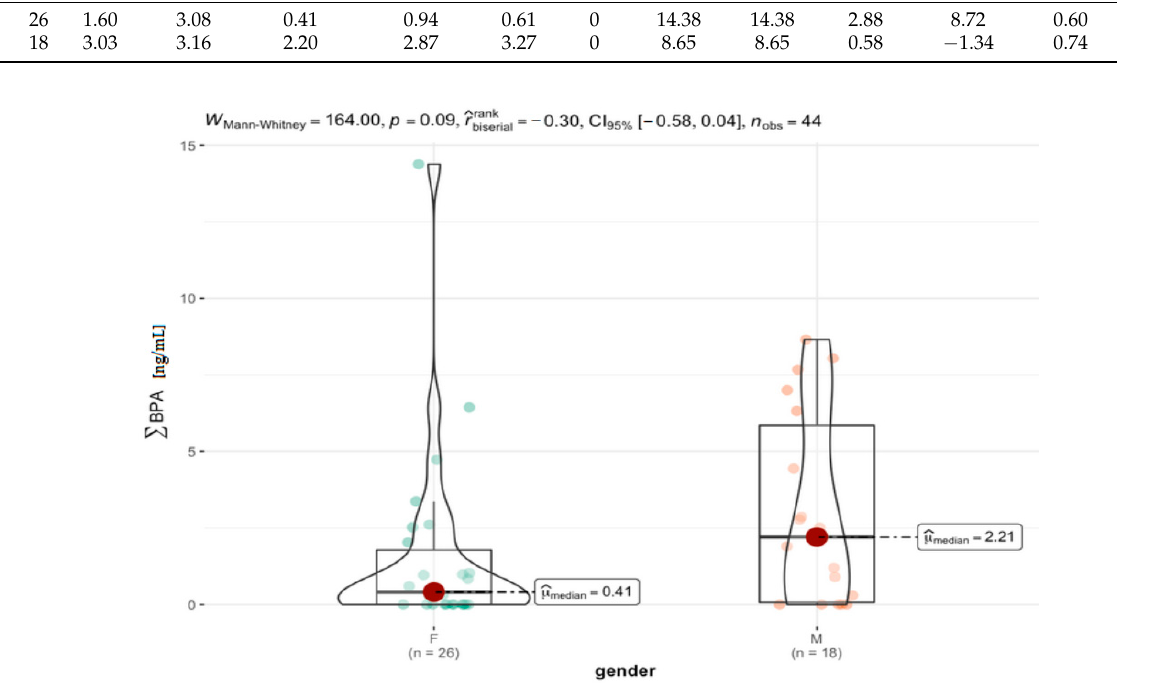
Table 7. Descriptive statistics for cataract group and cataract with coexisting ocular pathologies (glaucoma, AMD)